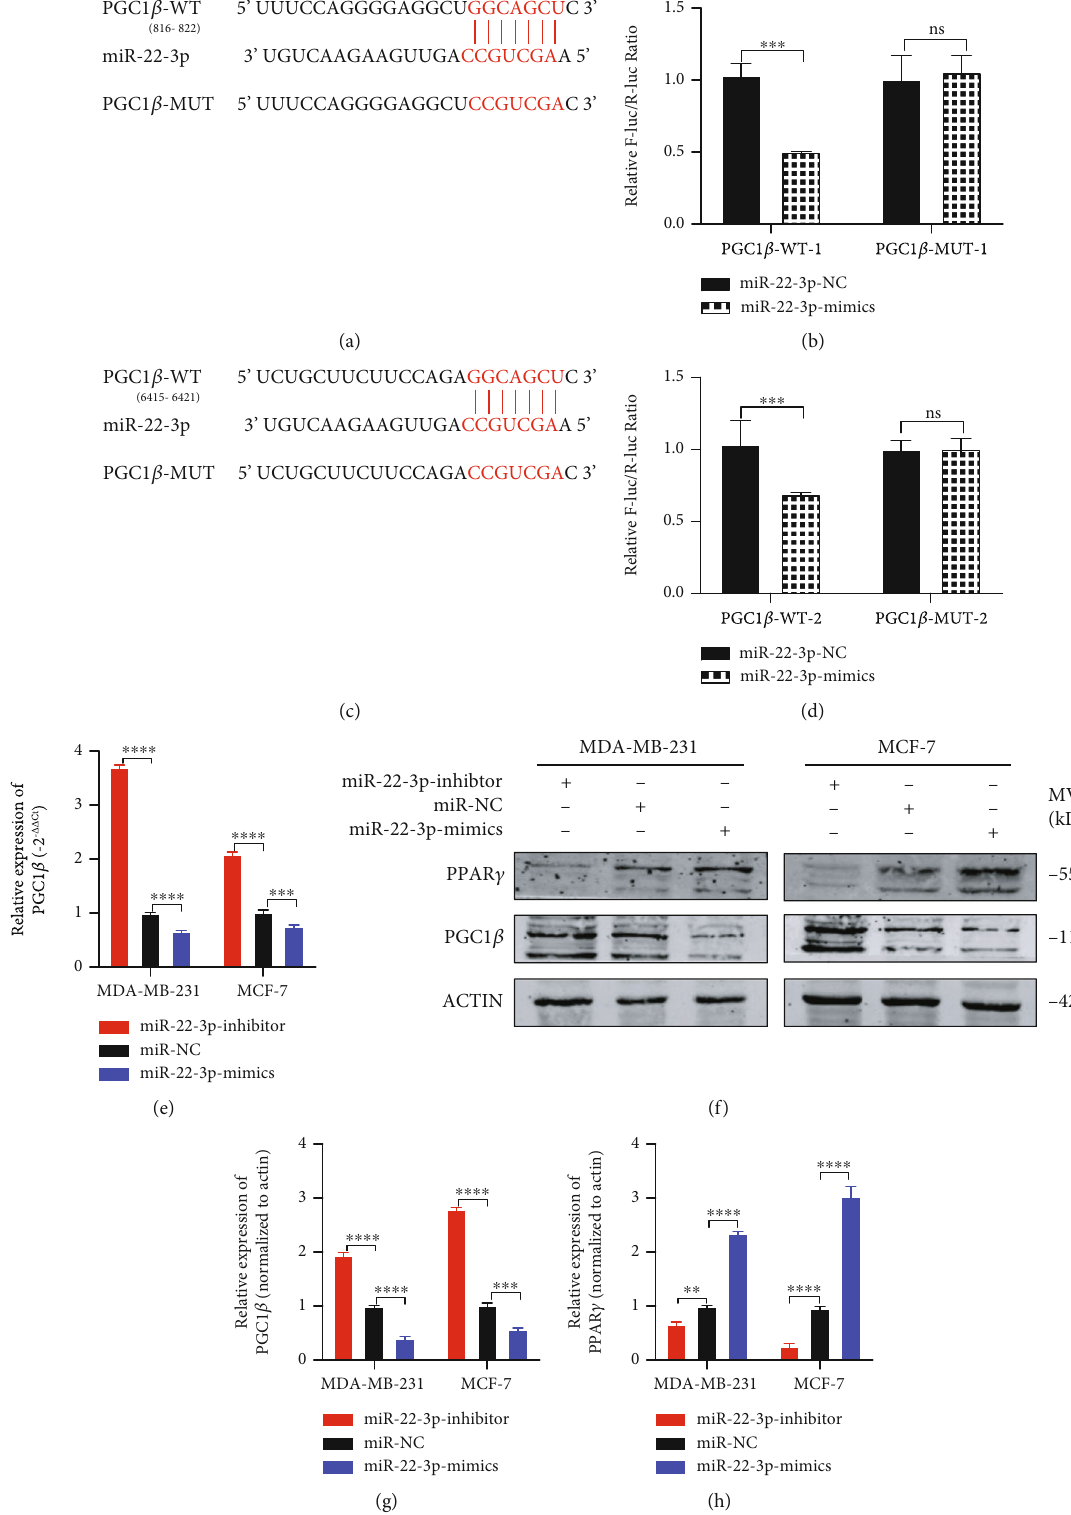
Figure 4: PGC1 β is a direct target of miR-22-3p. (a, c) Putative complementary sites within miR-22-3p and PGC1 β predicted by bioinformatics analysis (TargetScan). (b, d) Dual-luciferase reporter assays demonstrated that PGC1 β is a direct target of miR-22-3p. (e) PGC1 β mRNA level was determined by RT-PCR in MDA-MB-231 and MCF-7 cells with di ff erent treatment. (f – h) Representative western blots and quanti fi cation of PGC1 β and PPAR γ in MDA-MB-231 and MCF-7 cells with di ff erent treatment. β -Actin was used as an internal control. ∗∗ p < 0 : 01 ; ∗∗∗ p < 0 : 001 ; ∗∗∗∗ p < 0 : 0001